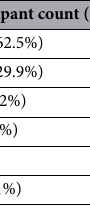
Table 1. Age demographics of the study